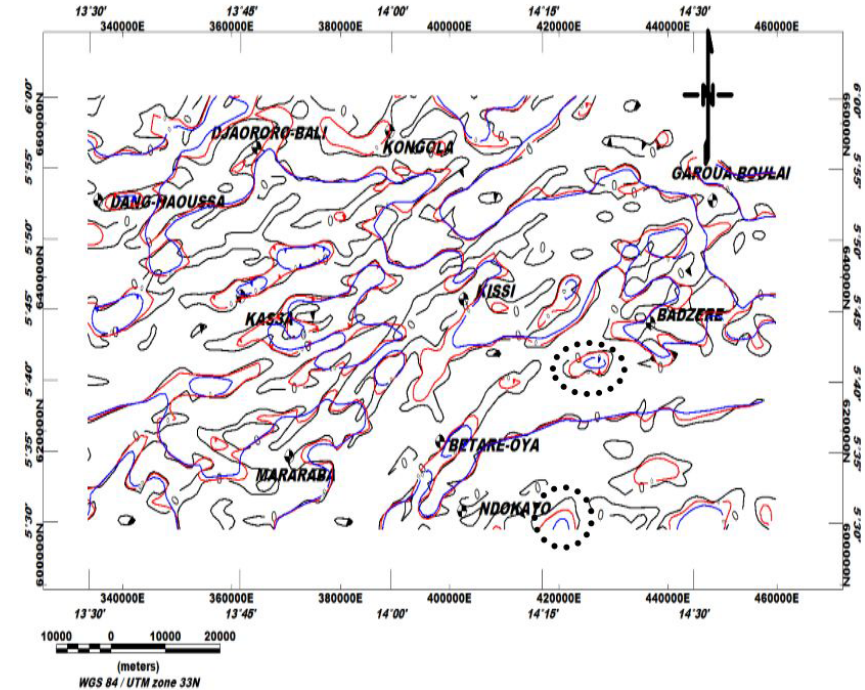
Figure 8. Superposition of contours ( O = 0 ◦ ) of tilt angle of upward data RTE continued to 1km (red) and 2km (blue).